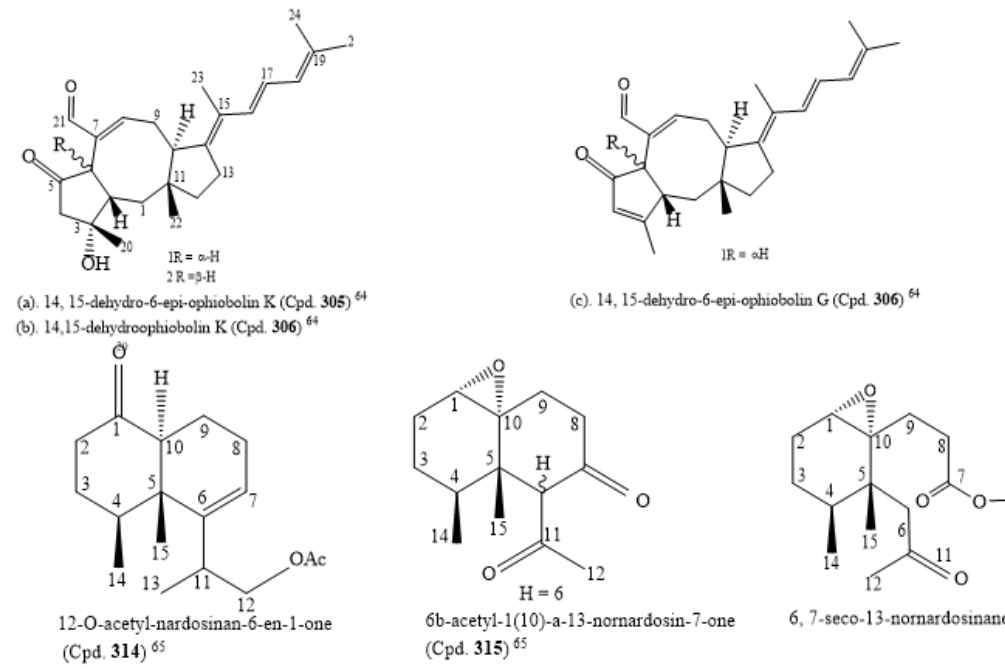
Figure 2. The structures of novel marine-derived terpenes and terpenoid compounds cytotoxic to cancer cell lines at IC 50 ≤ 1 µM.